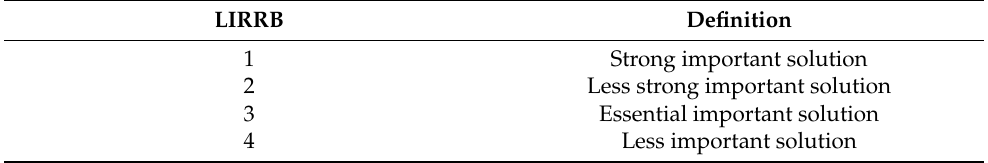
Figure 8. Priority scores of ESO combination in ( a ) southern, ( b ) western, ( c ) central, ( d ) northern, ( e ) eastern, under pro-economic; and ( f ) southern, ( g ) western, ( h ) central, ( i ) northern, ( j ) eastern under pro-environmental. Table 5. LESRB solution